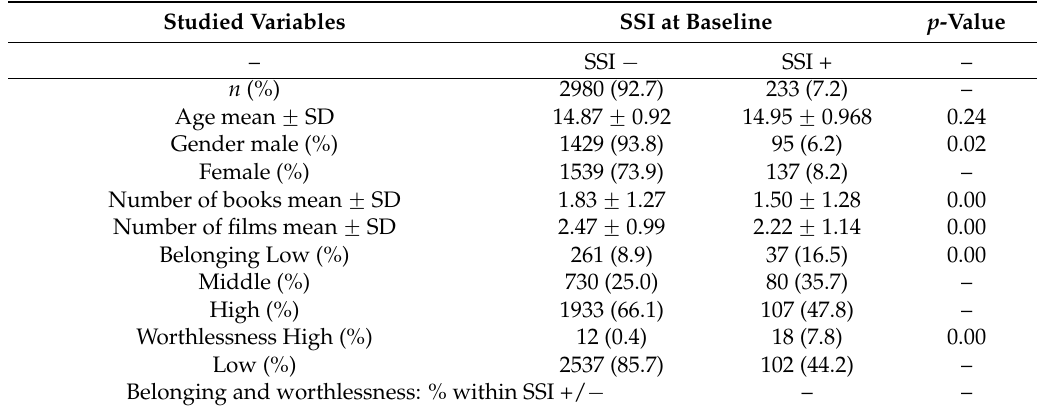
Table 1. Description of study